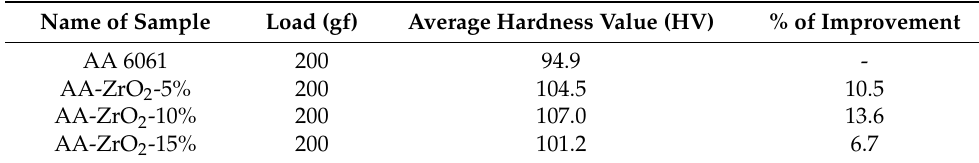
Table 3. Average hardness value of AA6061 and developed AA6061/ZrO 2 composite.